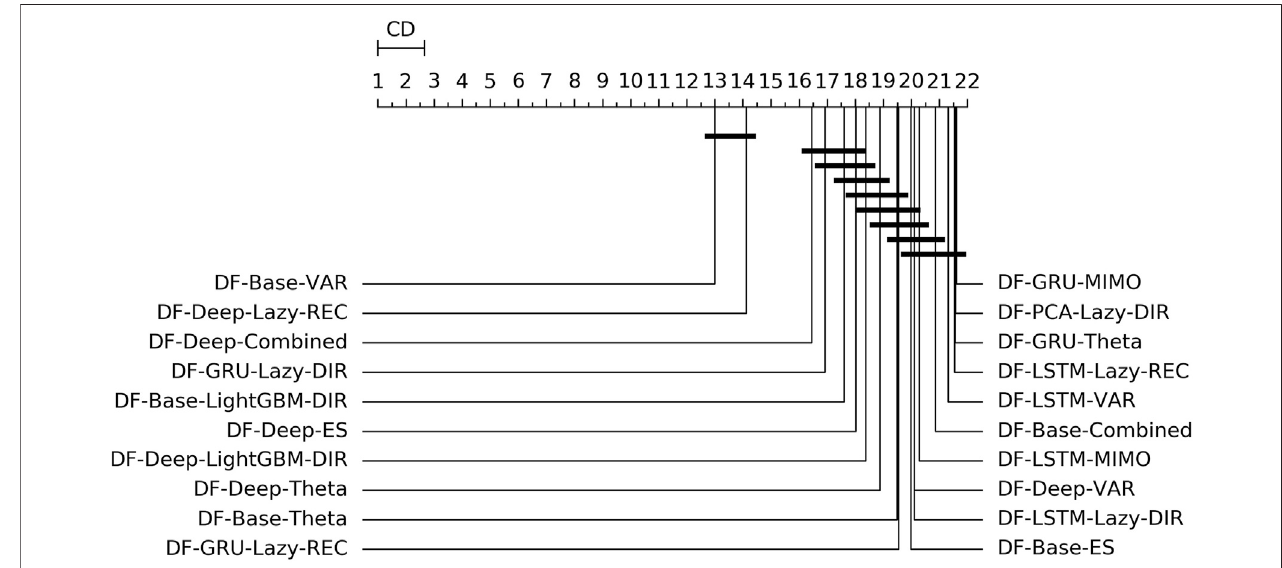
FIGURE 3 | Mobility — Graphical representation according to (Dem š ar, 2006) of the results of Friedman statistical test (with post-hoc Nemenyi test) comparing the NNMSE of the best 20 methods against each other, aggregated across all horizons h . The methods are ordered according to their performance from left to right (the leftmost the best), while the black bar connects methods that are not signi fi cantly different (at p (cid:1) 0.05).